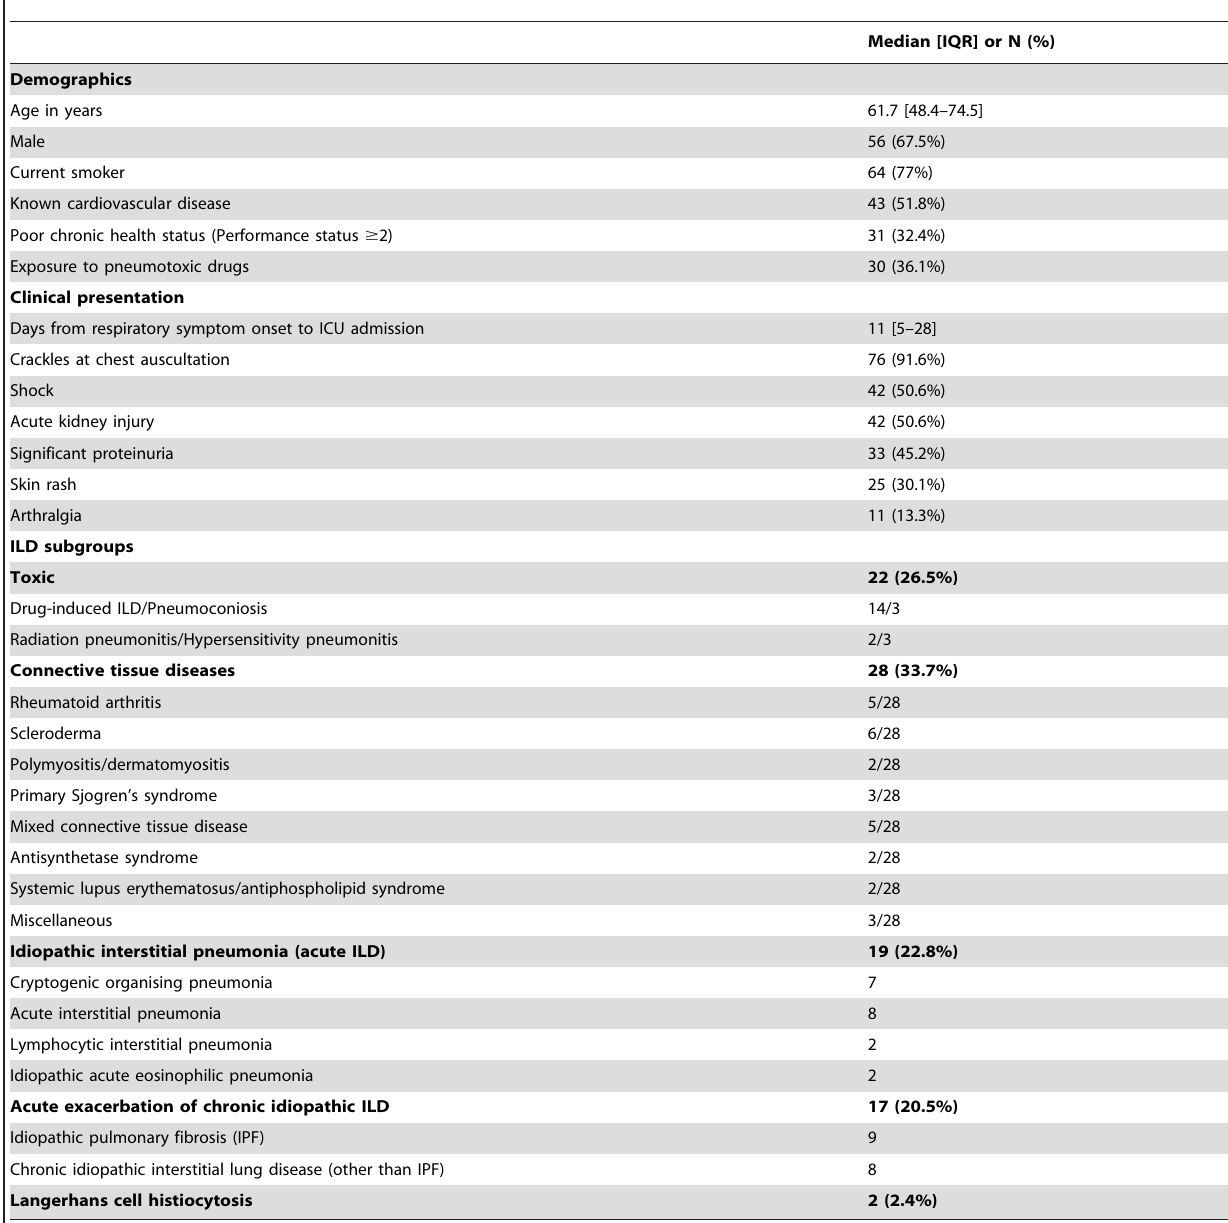
Table 1. Main characteristics of the 83 study patients at ICU